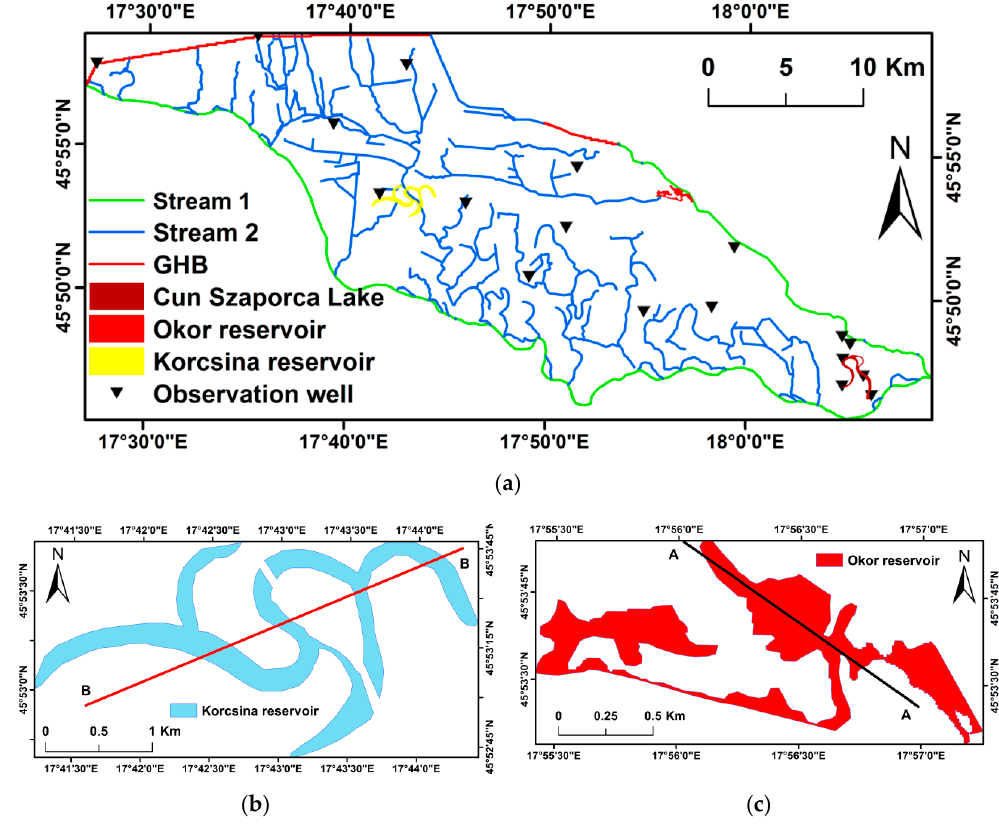
Figure 6. ( a ) Boundary conditions, observation wells, and planned reservoirs; ( b ) Korcsina reservoir; ( c ) Okor reservoir.